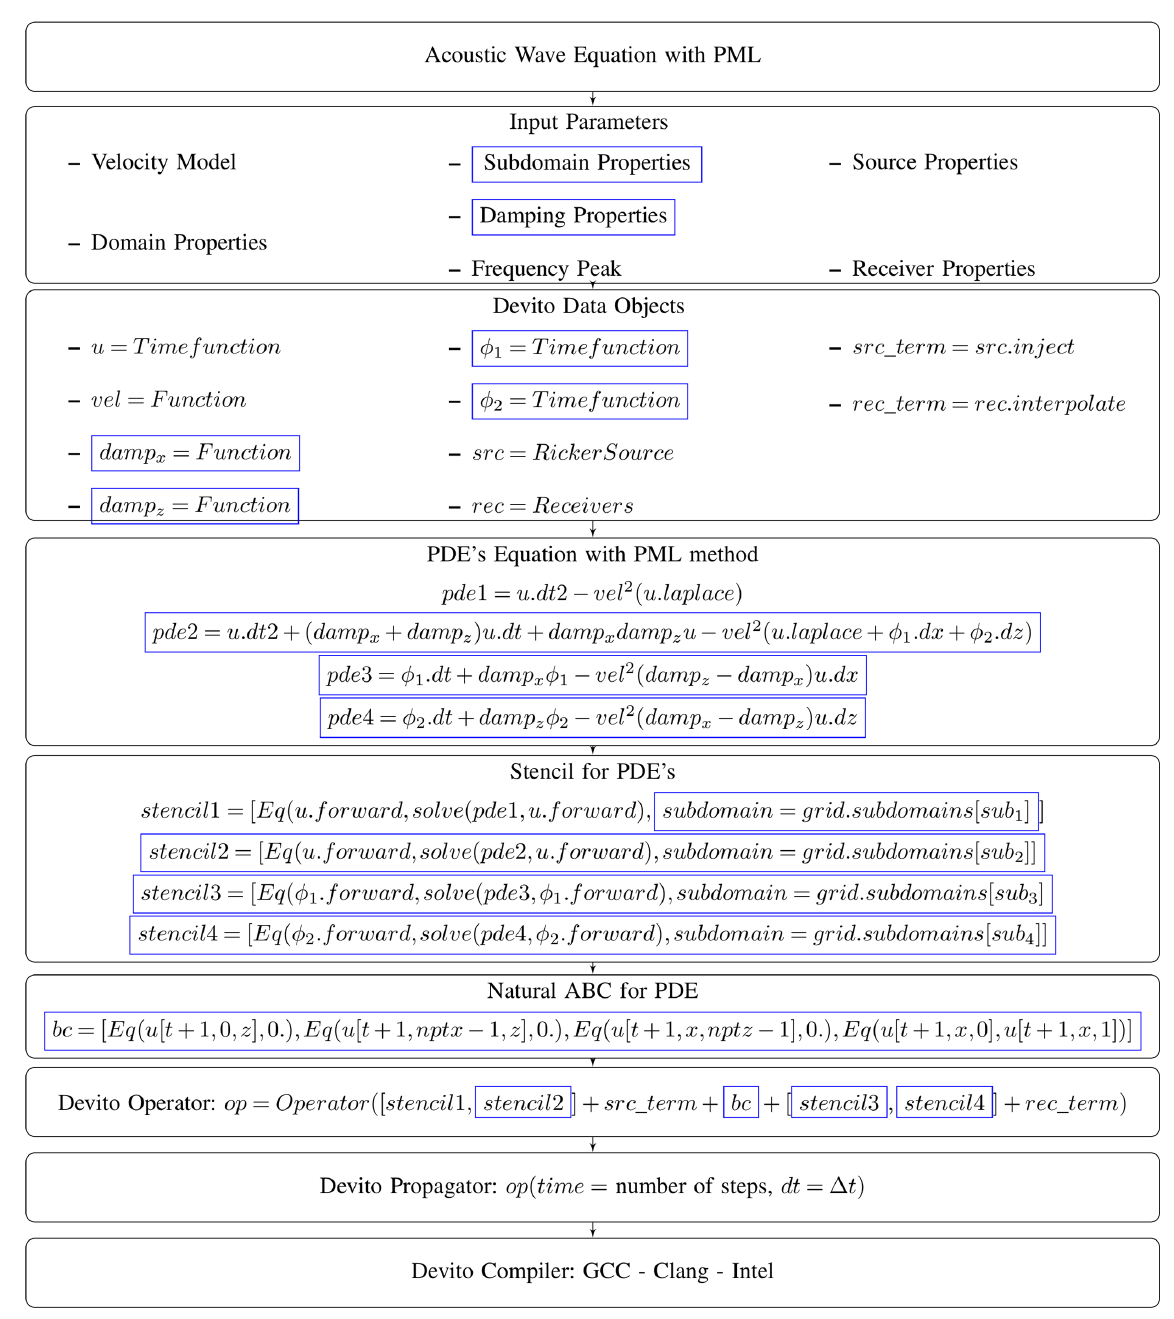
Figure 4. Example of logical implementation of PML method in the Devito coding framework. The diagram is similar to that of the original Devito development paper (Louboutin et al., 2019), but we highlight in blue boxes the kind of changes required for a PML implementation.